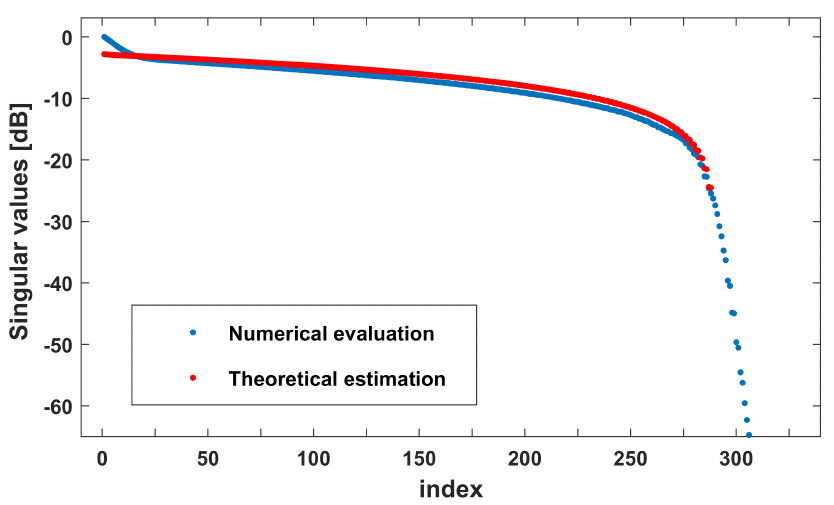
, A 1 A † , A 2 A † , A 2 A † for the case a = 20 λ , z 1 = 5 λ , 2 2 1 1